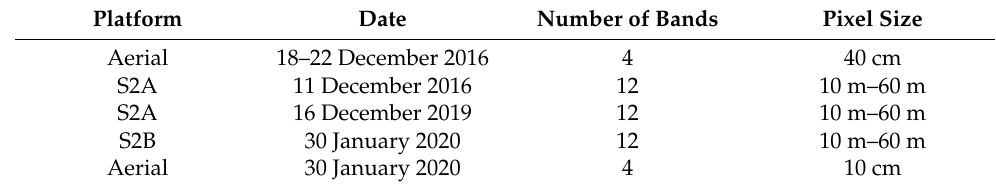
Table 2. Imagery used to assess fire effects from 2016 to 2020. Table shows date or range of dates for satellite (L2A) and aerial ortho-imagery collected, number of spectral bands and respective pixel size.